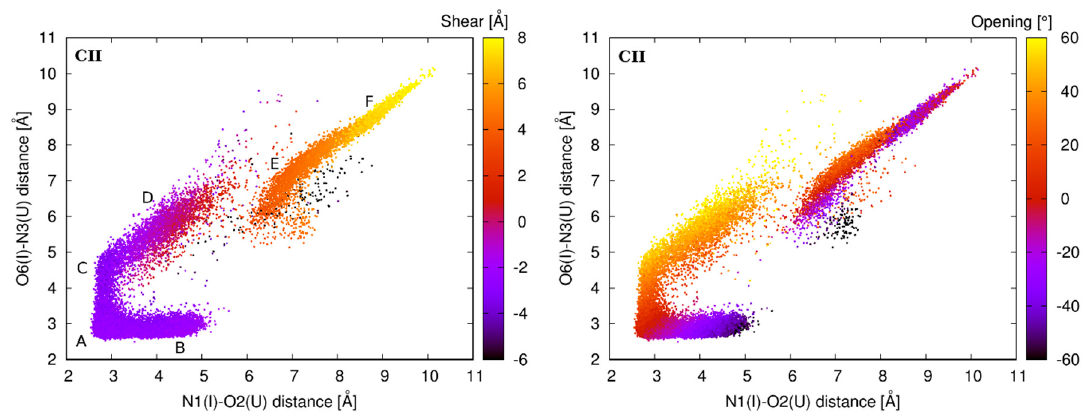
Figure 6. Distribution of the shear ( left ) and opening ( right ) parameters of the first I–U pair in CII system based on the unbiased molecular dynamics (MD) simulation. Color scale represents the shear/opening.